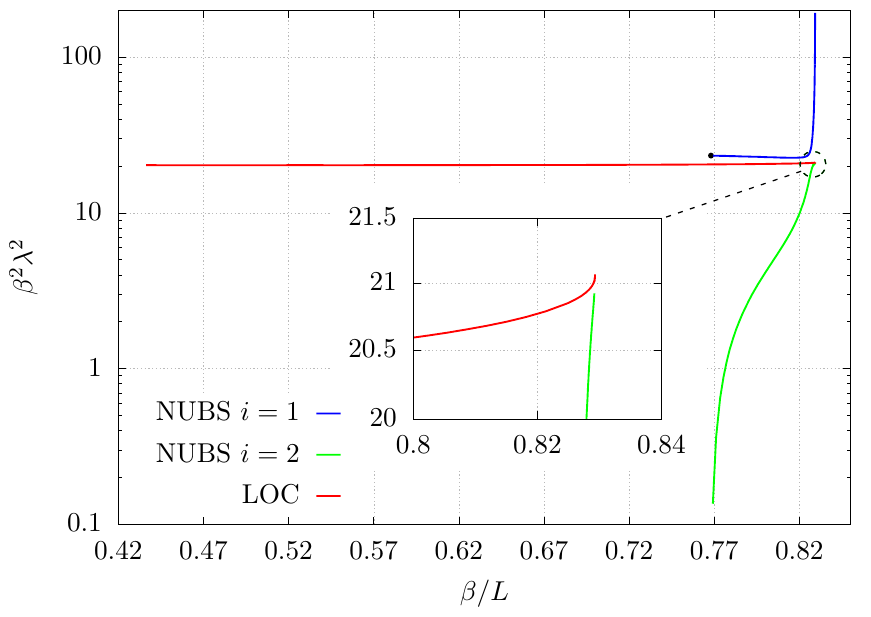
Figure 11 . Absolute value of the negative modes of NUBS (green and blue lines) and LOC (red line) normalized with respect to the inverse temperature of the NUBS and LOC as a function of the dimensionless ratio (cid:12)=L . The solid black discs show the zero mode and the negative mode of the UBS at the marginal GL